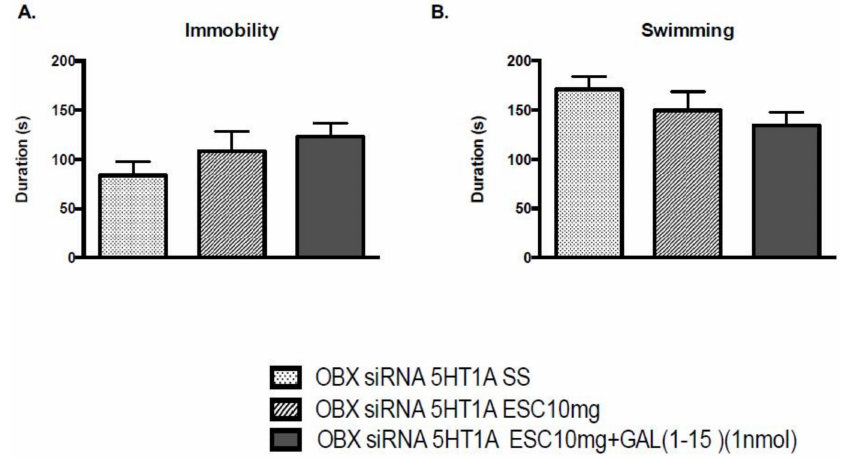
Figure 3. Behavioural effects of knockdown 5HT1A model of the coadministration of effective dose of ESC (10 mg/kg) and GAL(1-15) (1 nmol) in the forced swimming test (FST). Saline or ESC was administered intraperitoneal (ip) 23, 5, and 1 h before the test. aCSF or GAL(1-15) was injected intracerebroventricular (icv) 15 min before the test. Data represent mean ± SEM of immobility ( A ) and swimming ( B ) time in FST during the 5 min test period (n = 8–13 rats per group). There are no significant differences according to one way ANOVA followed by Fisher multiple comparison